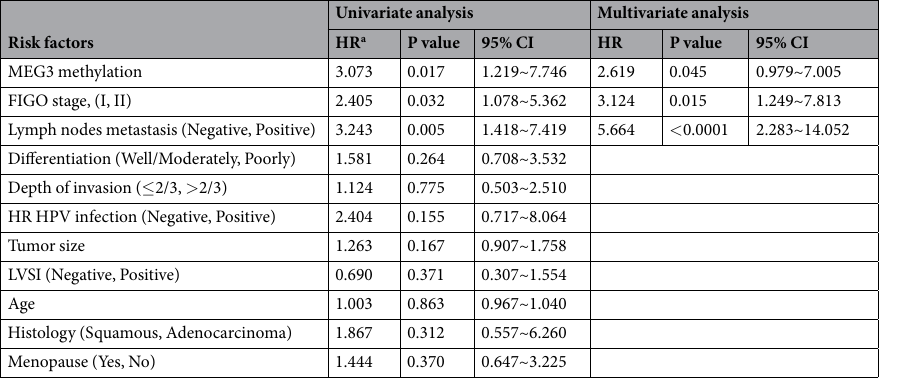
Table 5. Univariate and Multivariate analyses for recurrence-free survival. a HR (hazard ratio).